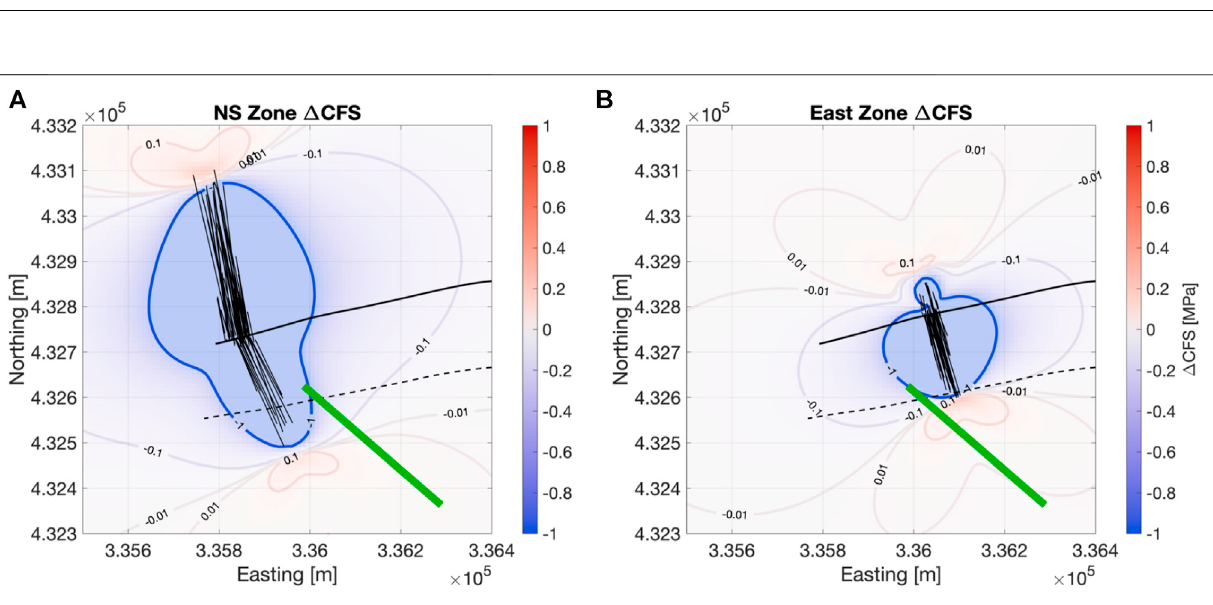
FIGURE6 | Maps of Δ CFS produced bythe NS Zone (A) and the Eastern Zone (B) at thedepthof thePNR-2 injection. In each case an exampleset of thefracture sources is shown by a population of black lines, the SEF zone by the green line, and the PNR-2 and PNR-1z well paths by the solid and dash lines respectively (as in Figure 5 ). Outside of the portion oflarge normal stress increase (with negative Δ CFS in blue) there is aregion on the SEfault beyond the fracture tips where shear stress increases and positive Δ CFS is promoting failure.